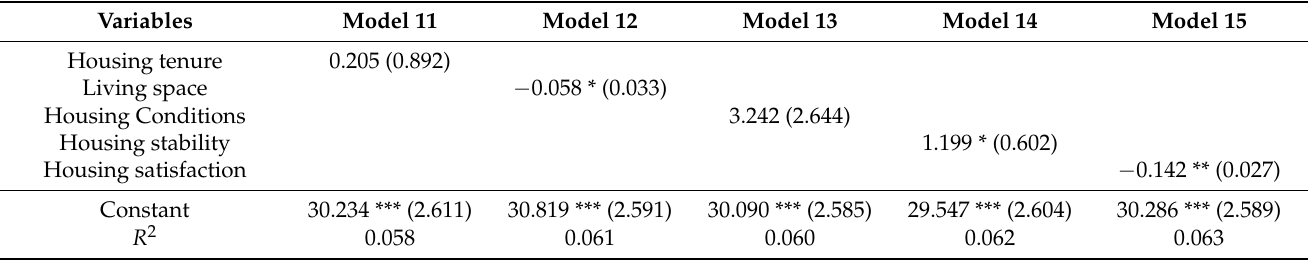
Table 5. Regression results of housing status and